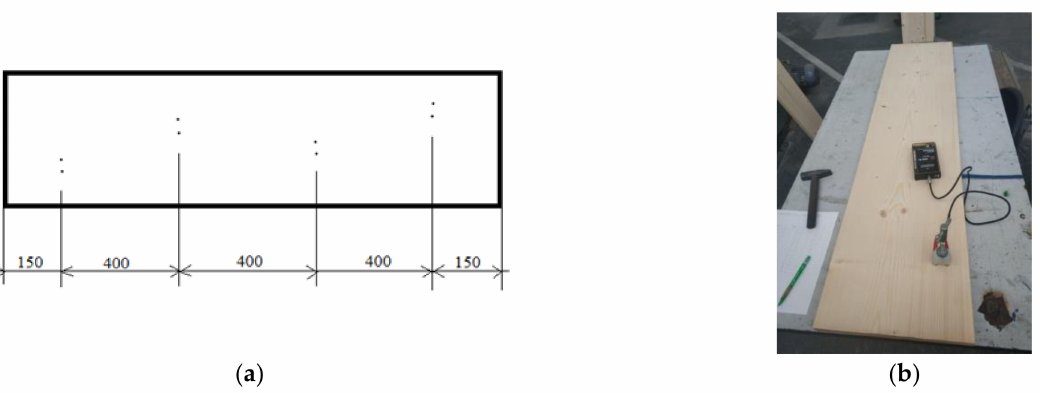
Figure 1. ( a ) Example of the location of humidity measuring points on the sample; ( b ) device for measuring humidity.